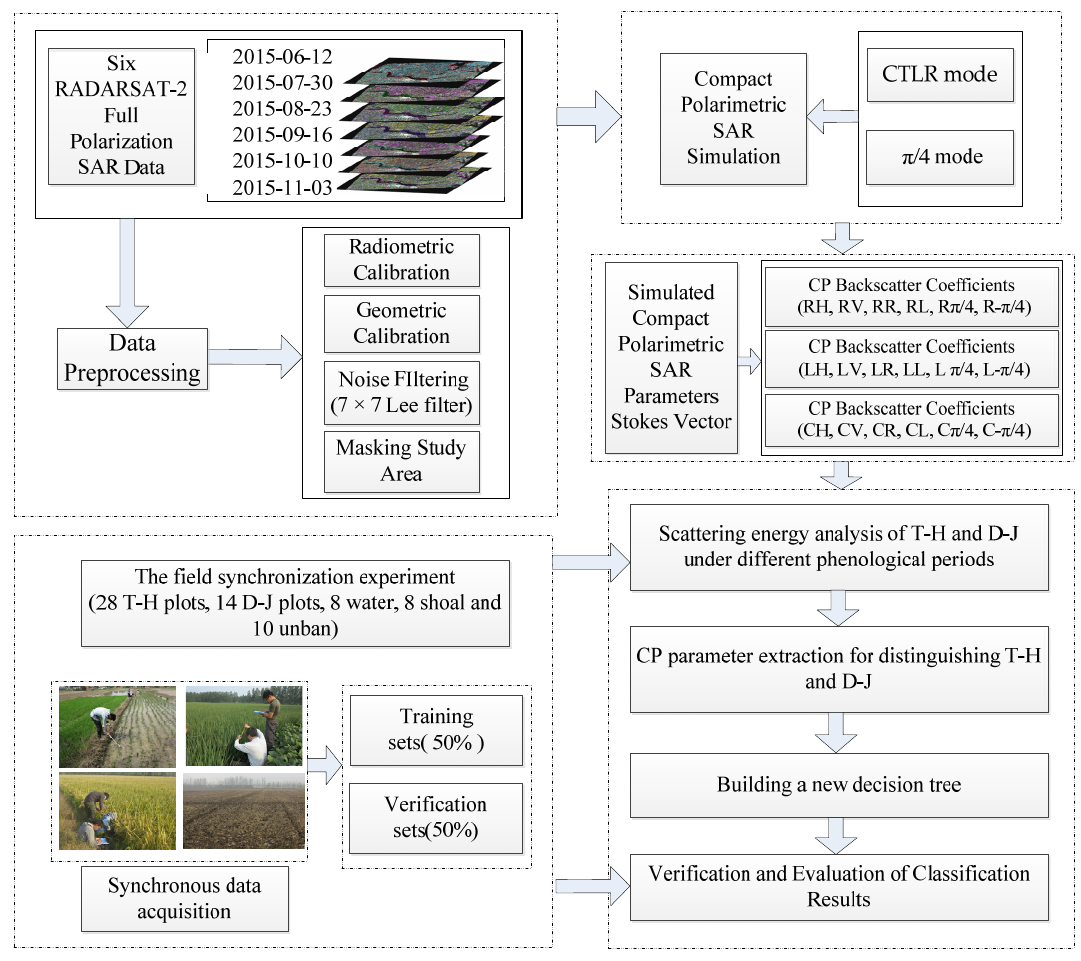
Figure 3. The specific flow chart.